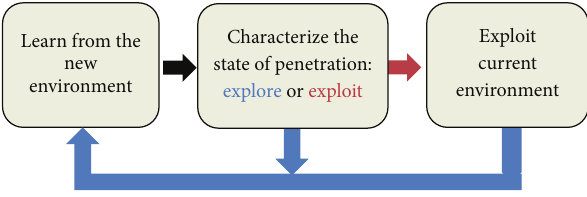
Figure 2: The scheme of acoustical indication in